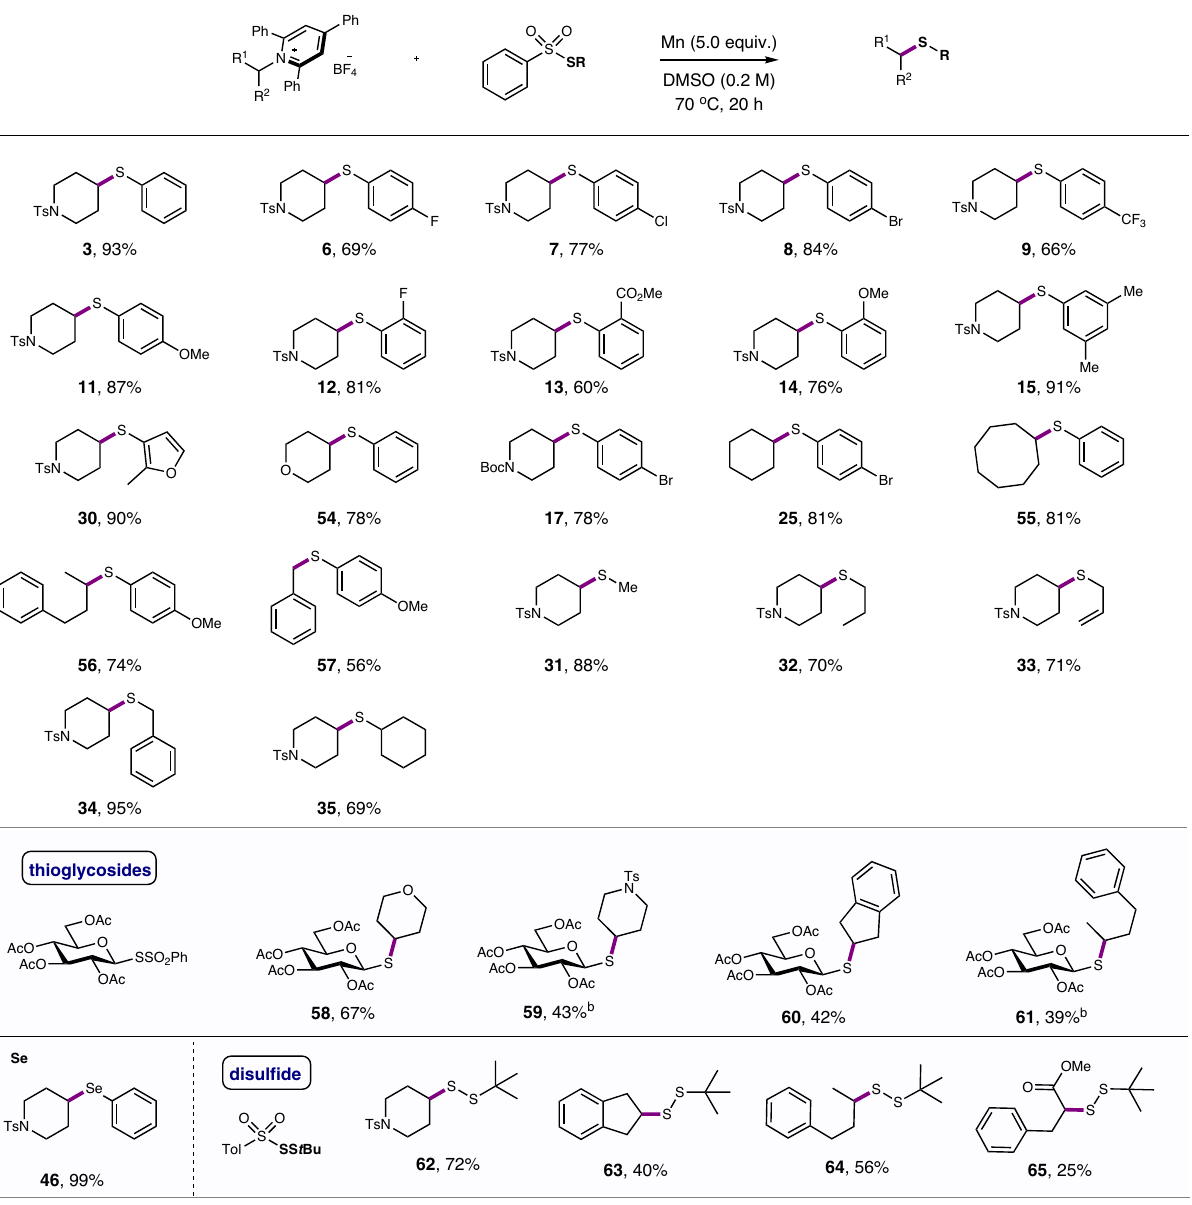
Fig. 5 Scope of deaminative thiolation. Reaction conditions: a N -alkylpyridinium salts (0.1 mmol), benzenesulfonothioates (0.25 mmol), Mn (0.5 mmol), in DMSO (0.2 M), 70 °C, N 2 , 20 h; yields are for isolated products. b Sulfonothioates (0.3 mmol), 80